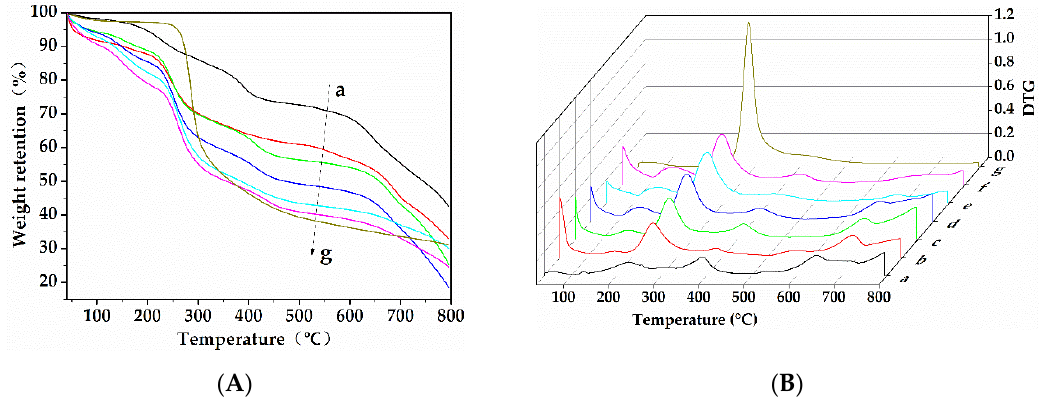
Figure 3. TG ( A ) and DTG ( B ) curves of (a) sodium lignosulfonate, L/C with different mass ratios of sodium lignosulfonate to chitosan: (b) 3:1, (c) 2:1, (d) 1:1, (e) 1:2, (f) 1:3, and (g) chitosan. Table 1. Results of TG-DTG curves of (a) sodium lignosulfonate, L/C with different mass ratios of